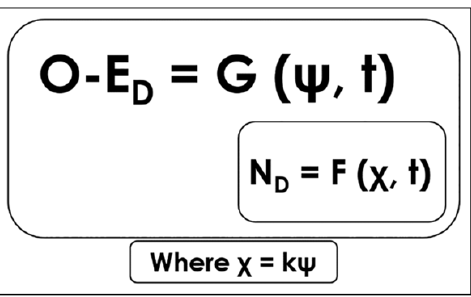
Figure 2. Model of resonance. O-E D is characterized as a function G of ecological information ψ and time. N D is characterized as a function of the variable χ and time. Ecological resonance occurs when ψ = k res χ , where k = k res . Reproduced from [27] (p. 409).